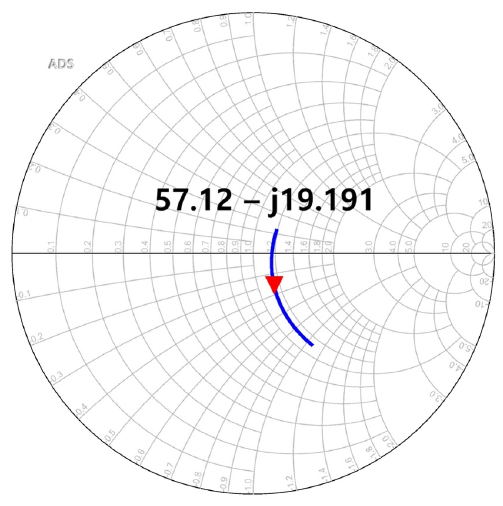
Figure 7. Simulated input impedance at a single-ended port of the detector core.